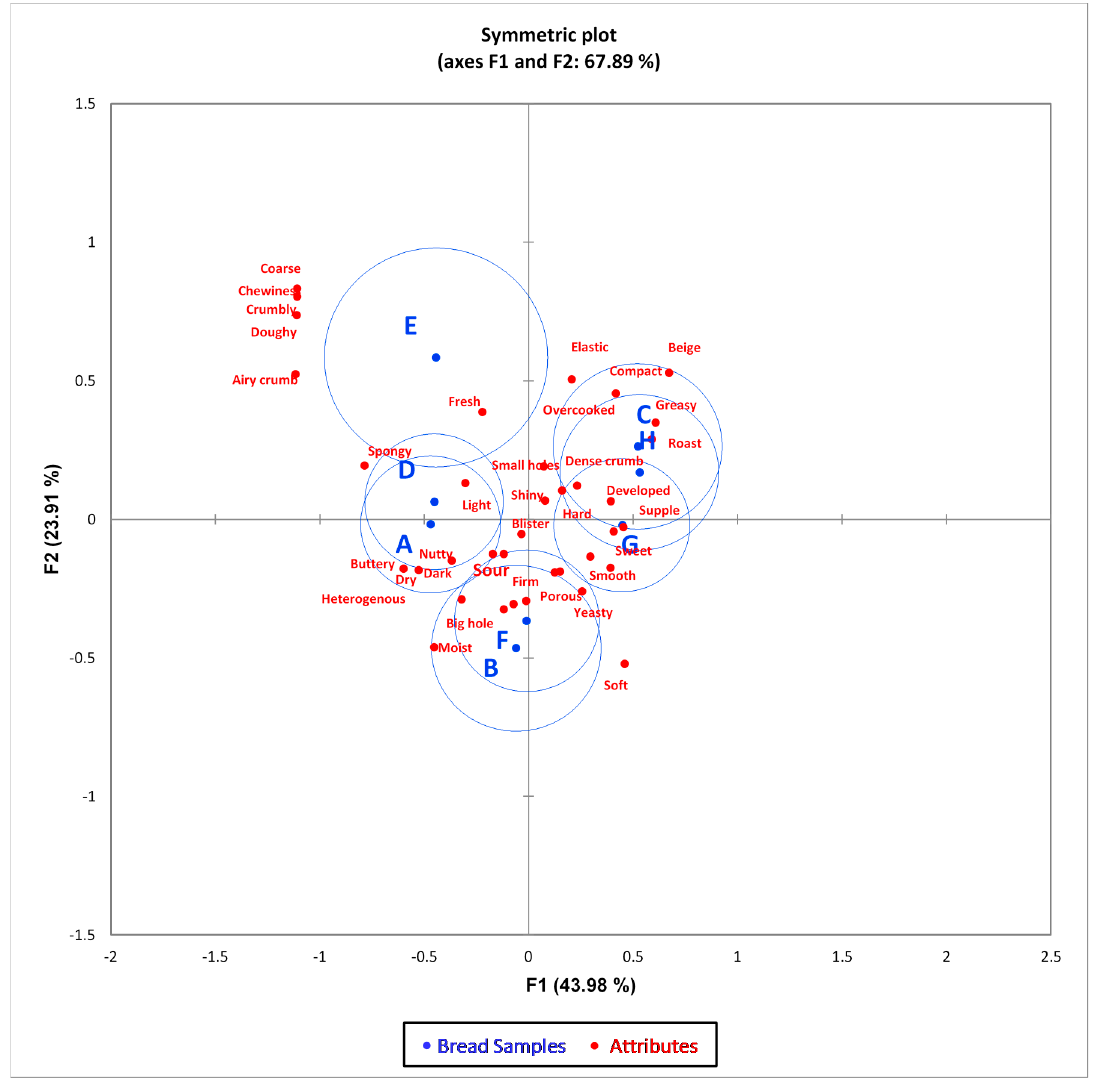
Figure 1. Correspondence analysis plot (with CI 95% based on chi-square distance) of CWK fermented sourdough bread samples A–H, using check-all-that-apply results. Starter culture used in bread samples A–H are shown below: A: 8.30 log CFU/mL of L. fermentum , 1.16 g of dry yeast and fermented for 18 h. B: 8.30 log CFU/mL of L. fermentum , without dry yeast and fermented for 24 h. C: 4.90 log CFU/mL of L. fermentum , 1.16 g of dry yeast and fermented for 18 h. D: 4.90 log CFU/mL of L. fermentum , without dry yeast and fermented for 24 h. E: 9.60 log CFU/mL of L. plantarum , 1.16 g of dry yeast and fermented for 18 h. F: 9.60 log CFU/mL of L. plantarum , without dry yeast and fermented for 24 h. G: 5.00 log CFU/mL of L. plantarum , 1.16 g of dry yeast and fermented for 18 h. H: 5.00 log CFU/mL of L. plantarum , without dry yeast and fermented for 24 h. Table 6. Cosine values between bread product and the attributes used to describe the samples, obtained by Correspondence Analysis (CA) for eight sourdough bread samples using CATA questions.